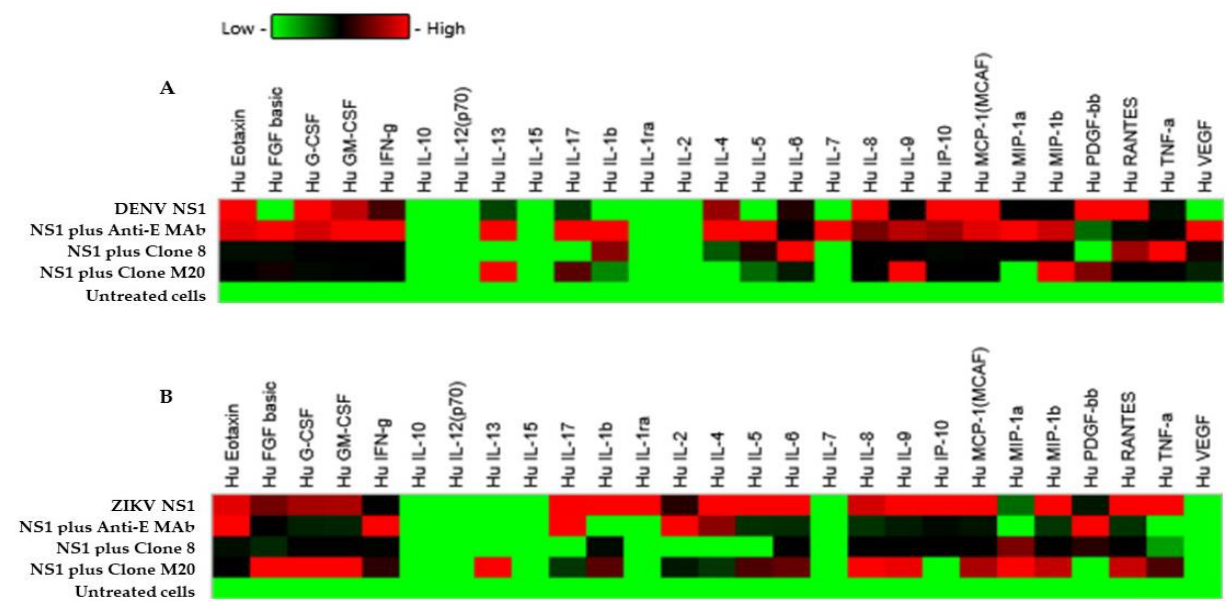
Figure 5. Effect of DENV NS1 HuMAbs to NS1-mediated inflammatory cytokines secretion in vitro: HMEC-1 and HUVECs cells were grown on Transwell inserts and incubated with ( A ) DENV NS1 and ( B ) ZIKV NS1 alone or NS1 with either anti-E HuMAb or anti-DENV NS1 HuMAbs; M20 and 8. Untreated cells are used as a negative control. The heatmap of cytokine production of DENV NS1- treated HMEC-1 cells and ZIKV NS1-treated HUVECs cells are analyzed, and the level of cytokine series is measured using human cytokine multiplex assay at 24 h post-treatment. Data are derived from two independent experiments, each with duplicate samples. Table 3. Statistical analysis of effect of DENV NS1 HuMAbs to both DENV NS1 and ZIKV NS1- mediated inflammatory cytokines secretion in vitro compared to untreated cells.